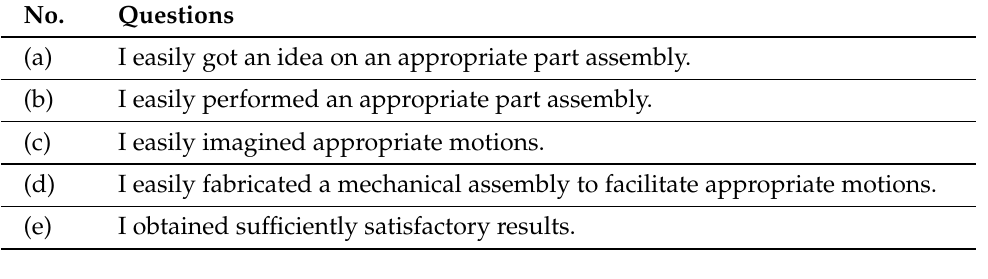
Table 3. Survey questions.